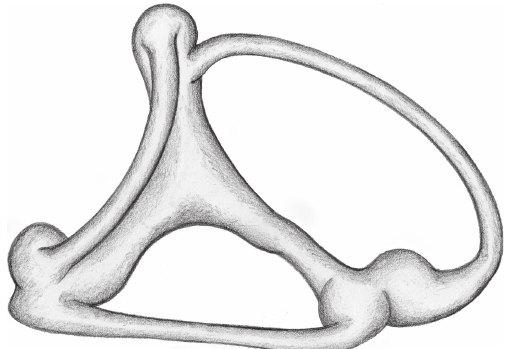
Figure 2: Artist’s depiction of a reconstructed vestibular labyrinth in the Oyster Toadfish (after Ghanem).